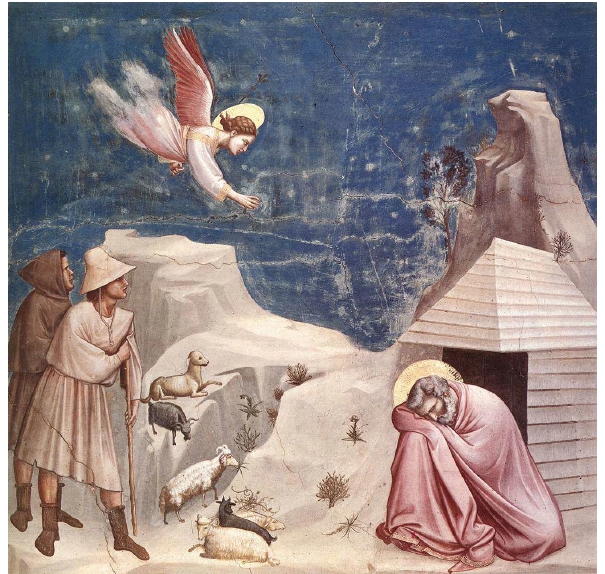
Figure 16. The dream of Joachim by Giotto (1304–1306). Scrovegni (Arena) Chapel, Padua, Italy. Source: public domain – Wiki Commons.